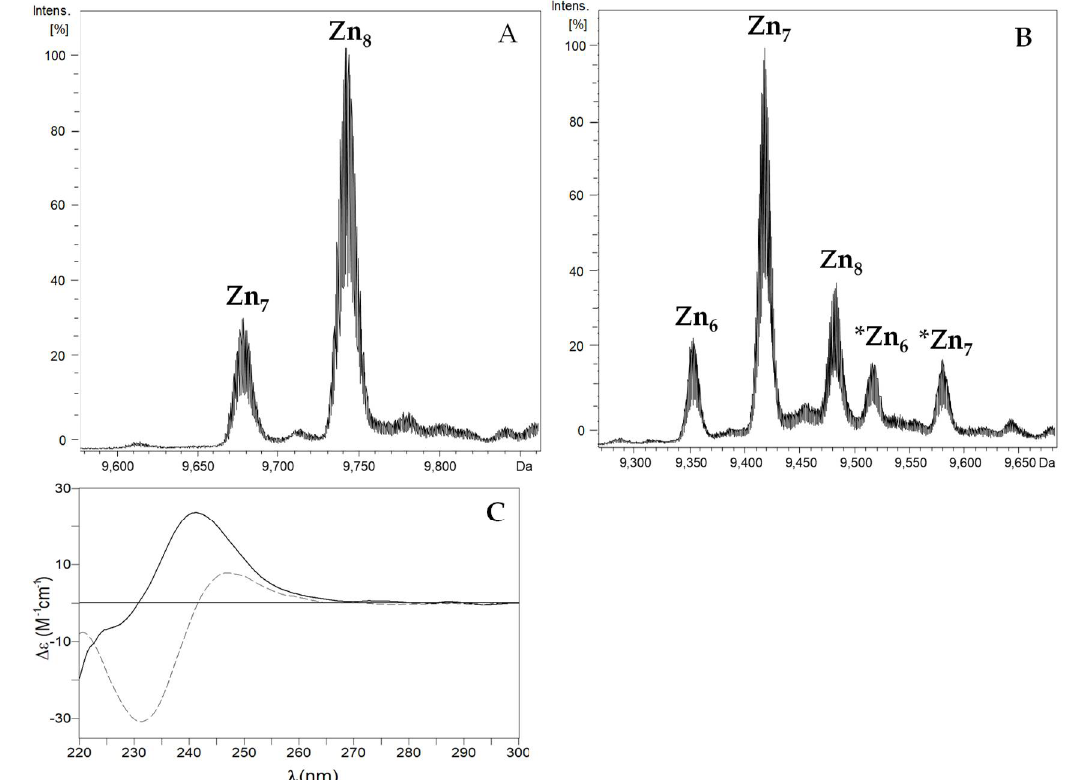
Figure 3. Deconvoluted ESI-MS spectra of the recombinant productions of ( A ) Zn-PbrMT1 and ( B ) Zn-PbrMT2 at neutral pH. ( C ) CD spectra of Zn-PbrMT1 (solid) and Zn-PbrMT2 (dashed) productions. Species with * correspond to metal complexes formed by